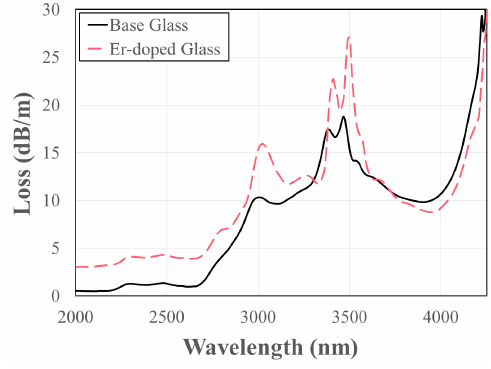
Figure 4. Measured fiber loss of the base tellurite glass and the Er-doped tellurite glass.